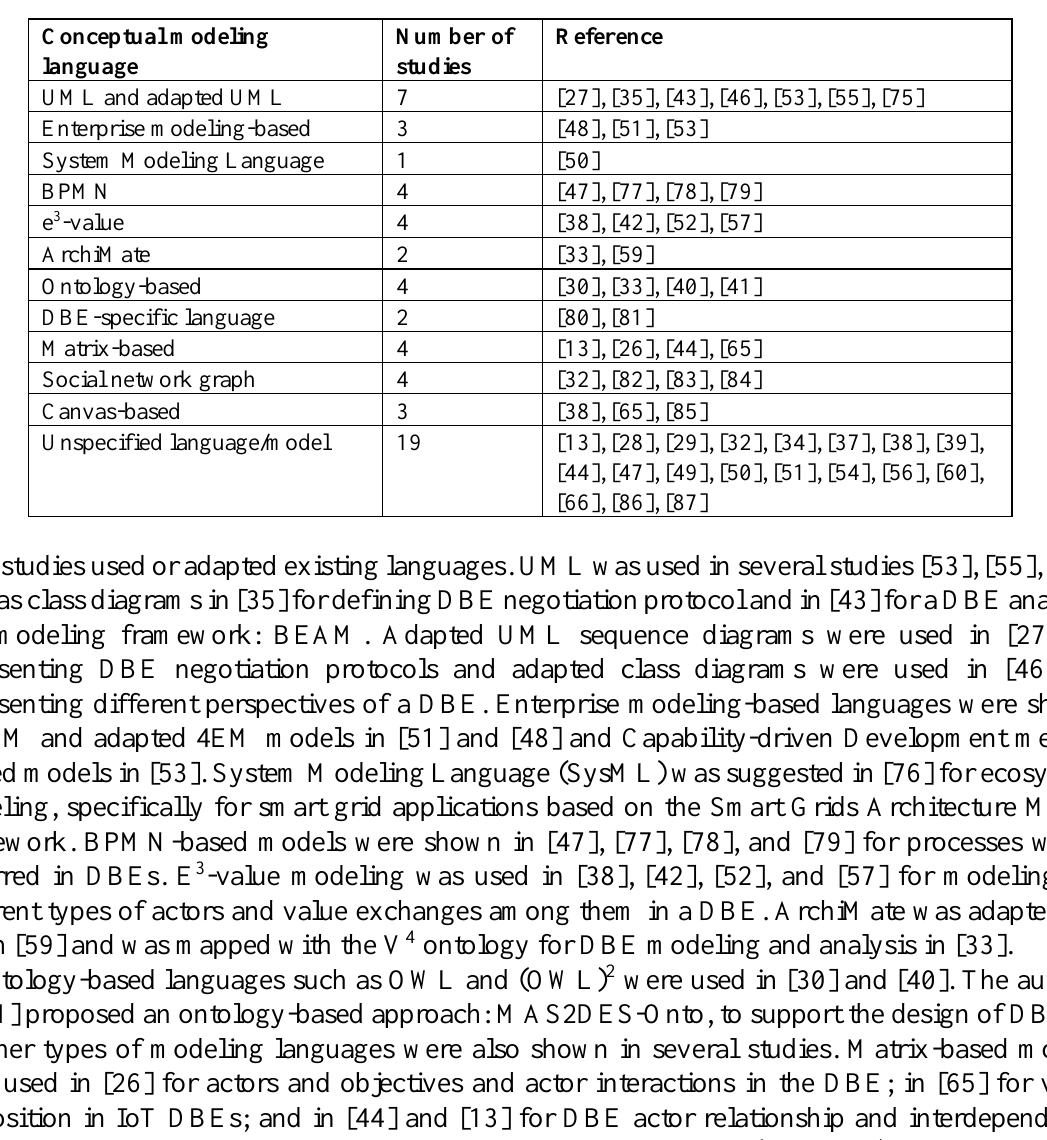
Table 5. Numbers and types of conceptual modeling